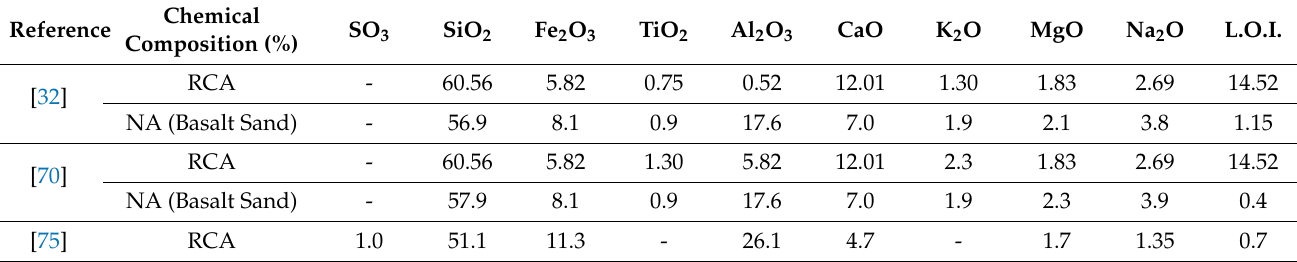
Table 2. Chemical composition of RCA and